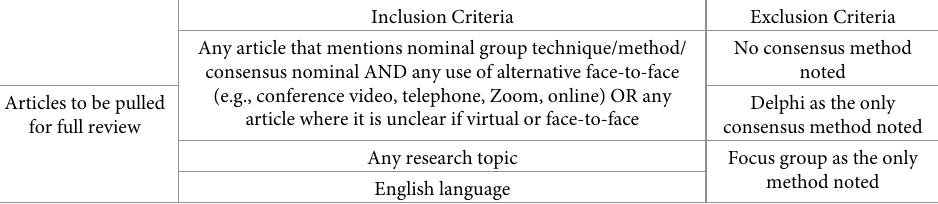
Table 1. Inclusion and exclusion criteria at title and abstract